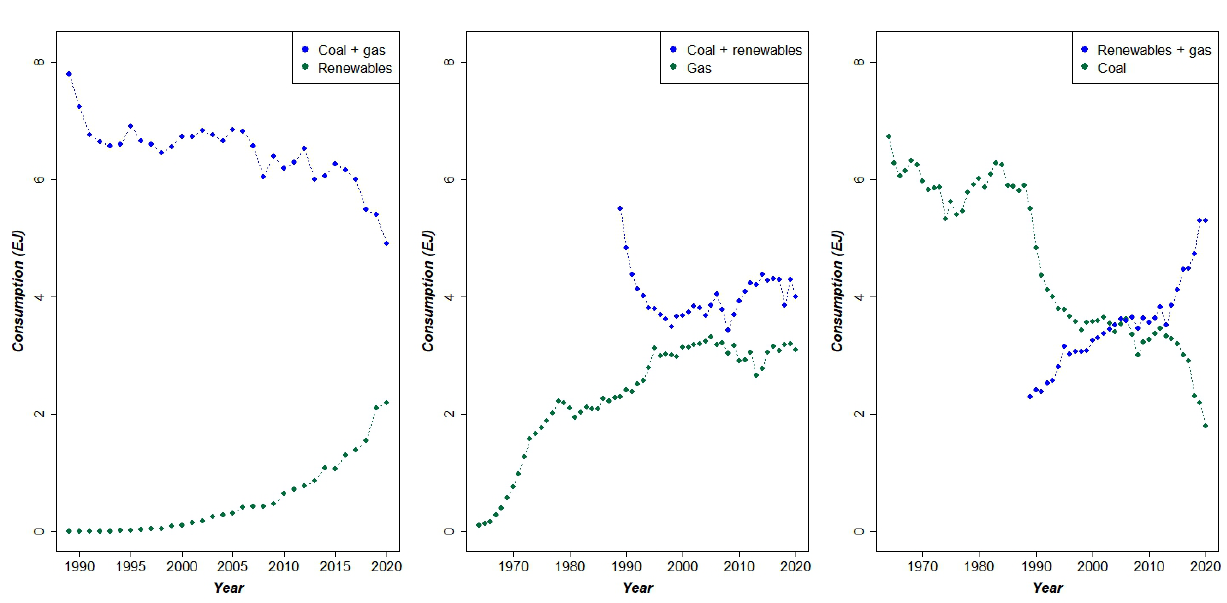
Figure A1. Relationships between energy sources as studied in the UCTT